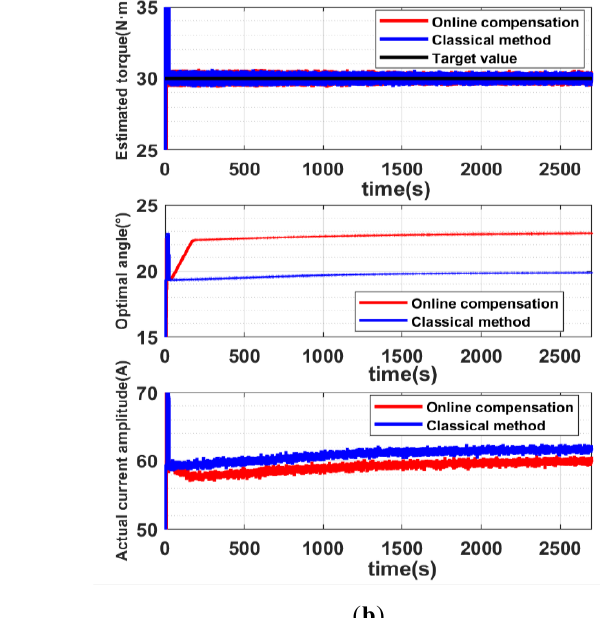
( b ) deviation flux change results.